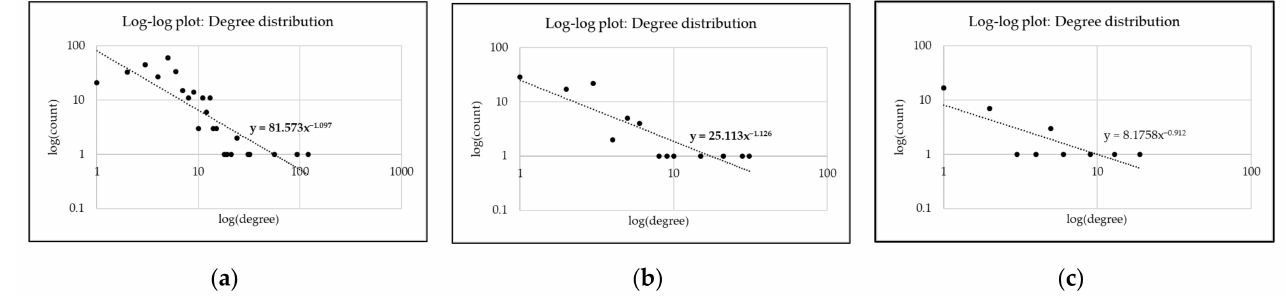
Figure 5. ( a ) Log-log plot of degree distribution depicted in Figure 4a; ( b ) Log-log plot of degree distribution depicted in Figure 4b; ( c ) Log-log plot of degree distribution depicted in Figure 4c.